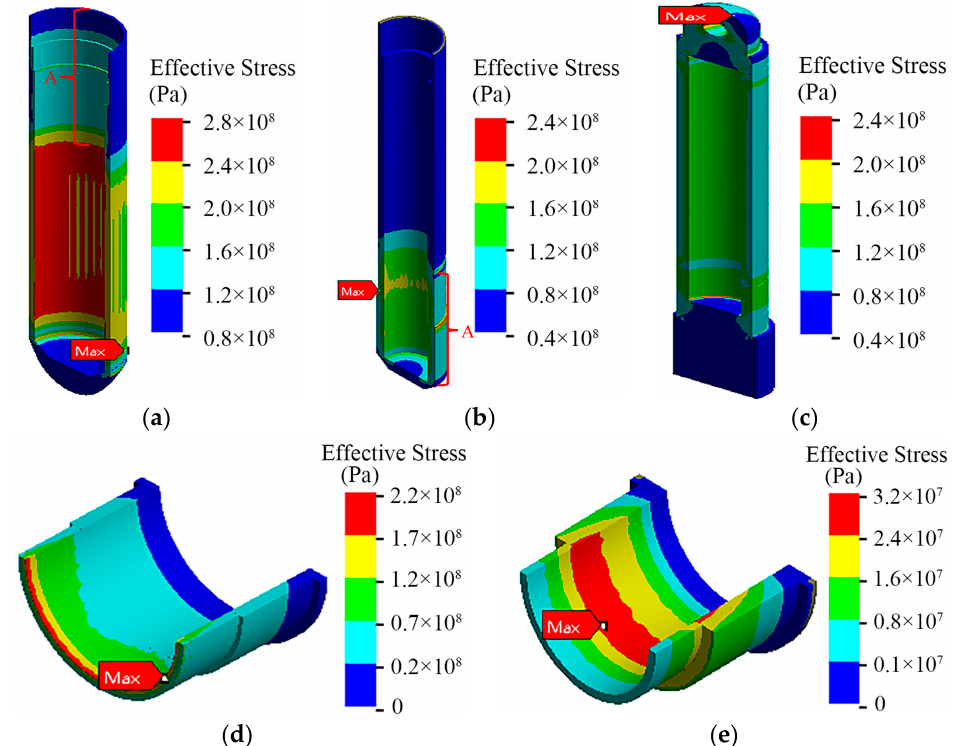
Figure 11. ( a ) Stress distribution of the one-level cylinder under condition ( a ). ( b ) Stress distribution of the two-level cylinder under condition ( a ). ( c ) Stress distribution of the movable column under condition ( a ). ( d ) Stress distribution of the hinged hole of the one-level guide sleeve under condition ( a ). ( e ) Stress distribution of the two-level guide sleeve under condition ( a ).